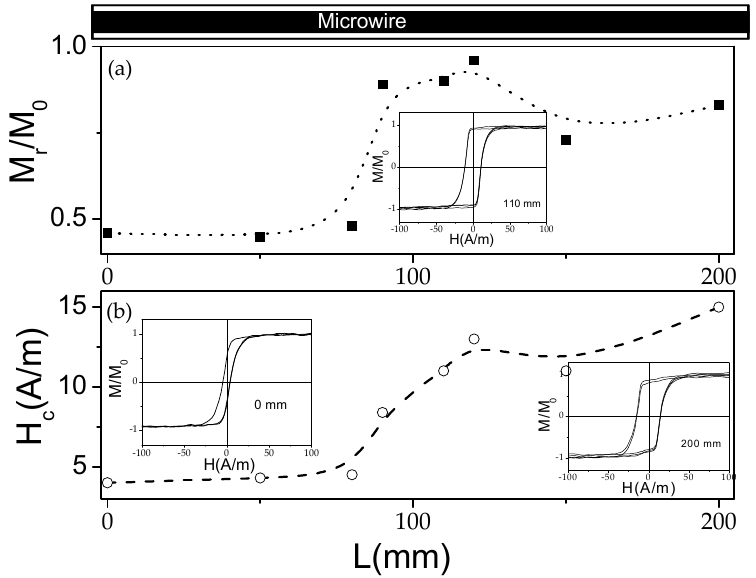
Figure 8. Variation of M r /M 0 ( a ) and H c ( b ) in the sample 2 annealed at variable T ann . The lines are just guides for the eyes.